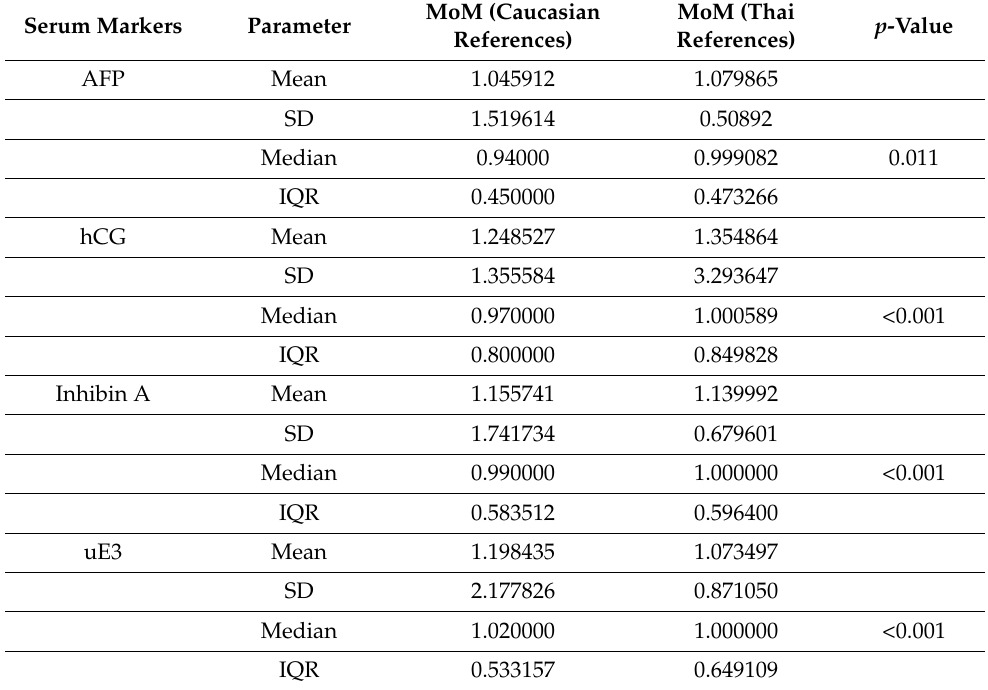
Table 2. Comparisons of MoMs derived from Caucasian and Thai references (Wilcoxon signed-rank